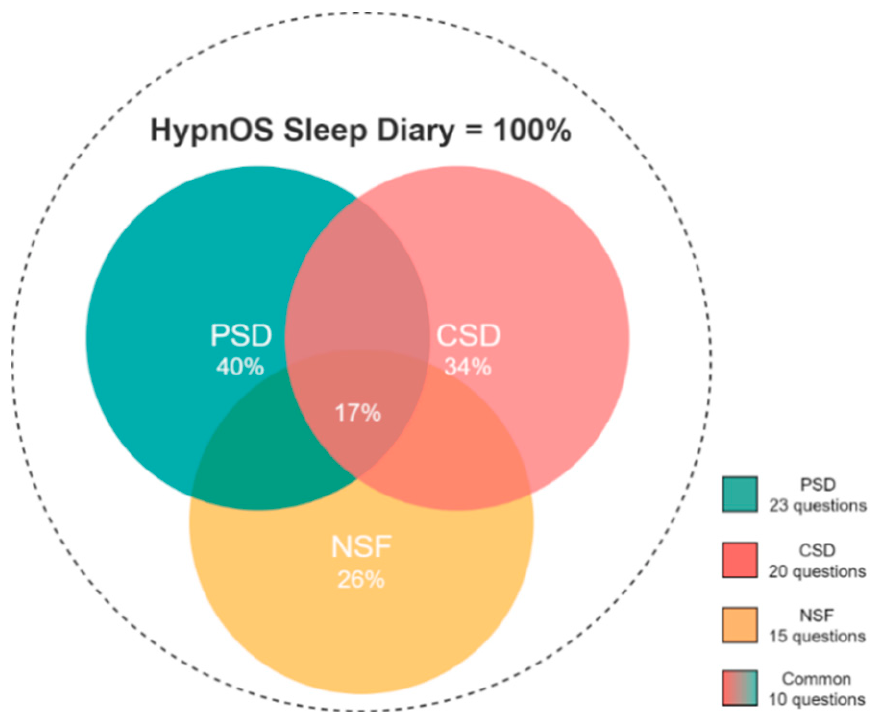
Figure 11. HypnOS Sleep Diary (HSD).